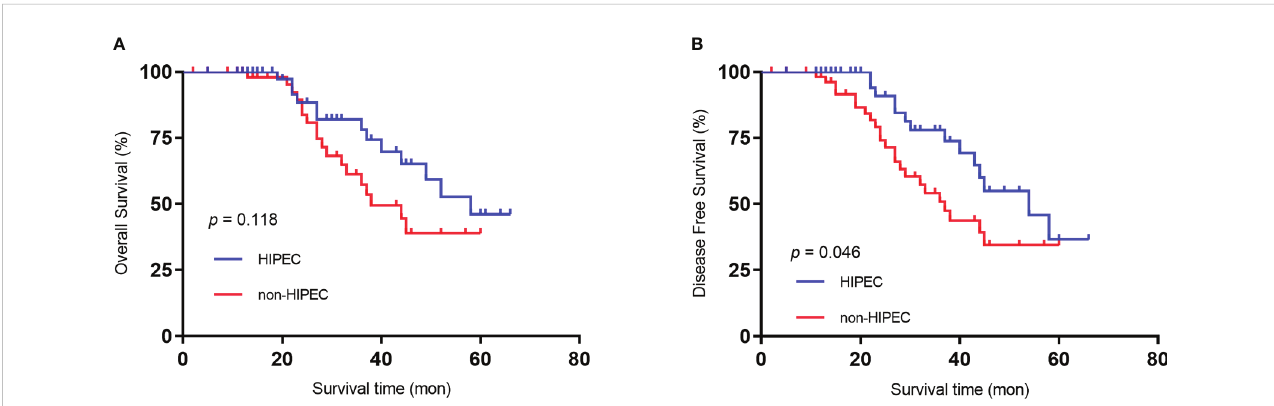
FIGURE 1 Kaplan ‒ Meier survival curves depicting the survival in patients with T4 gastric cancer. (A) Patient OS based on whether HIPEC was performed. (B) Patient DFS based on whether HIPEC was performed..